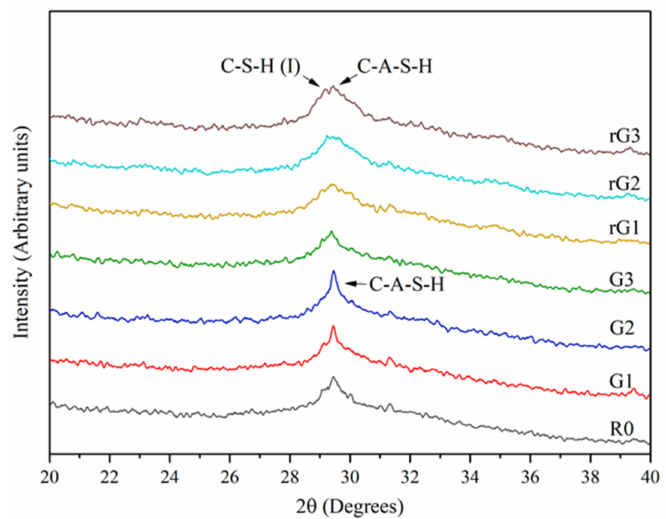
Figure 11. XRD patterns of the samples with GO/rGO